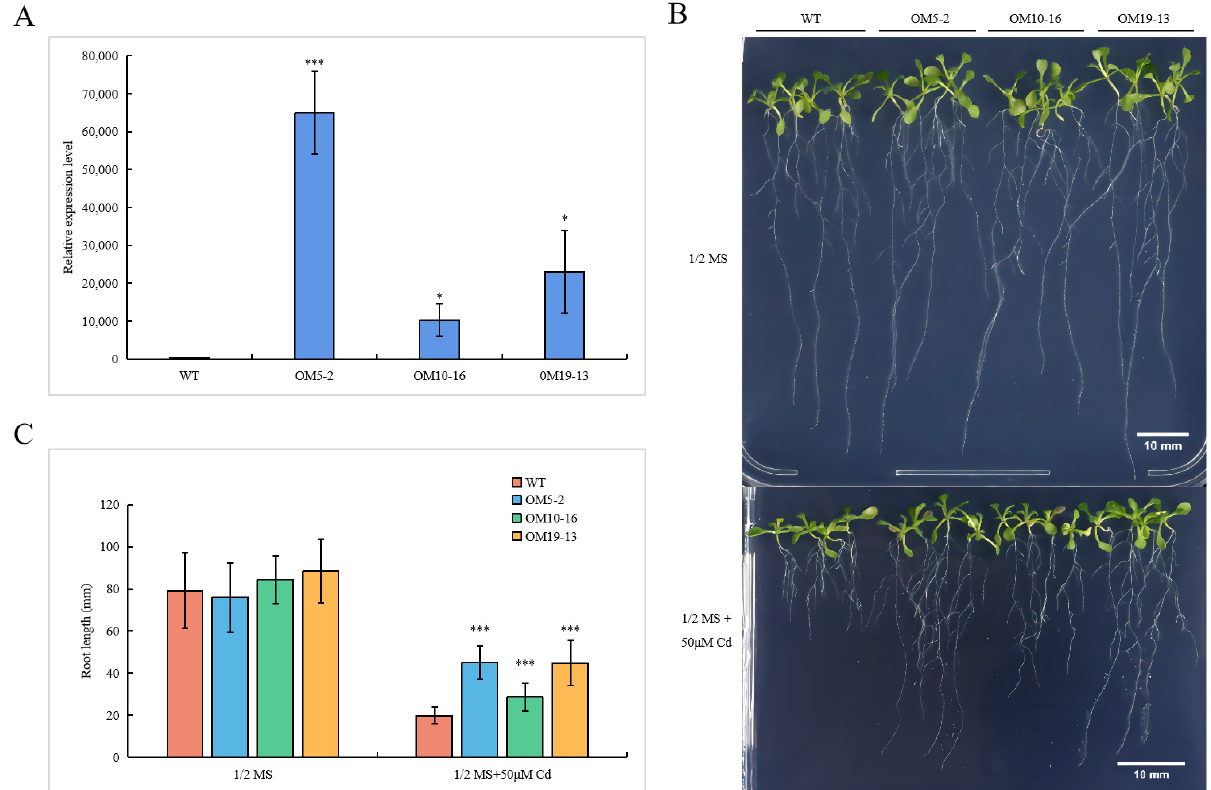
Figure 5. Analysis of PvHMA2.1 ectopically expressed lines in response to Cd treatment in A. thaliana . ( A ) Relative expression levels of PvHMA2.1 in the PvHMA2.1 ectopically expressed lines and the WT in Arabidopsis without Cd treatment. Specifically, 7-day-old Arabidopsis seedlings of the T 3 PvHMA2.1 ectopically expressed lines and the WT grown on a 1/2 MS medium were harvested for transcription detection using qPCR. The expression levels of PvHMA2.1 gene in the WT are normalized as 1. Error bars represent the standard deviations of the three replicates. ( B ) Phenotypic analysis of Arabidopsis seedlings under Cd stress. Specifically, 3-day-old Arabidopsis seedlings of the T 4 transgenic lines (OM5-2, OM10-16, and OM19-13) and the WT were grown in a 1/2 MS medium without Cd or with 50 µ M of Cd for 8 days, and photographs were taken. Scale bars are 10 mm. ( C ) Primary root lengths of Arabidopsis seedlings under Cd stress. Primary root lengths were measured using IMAGEJ 1.52, and the data represent the mean ± SD, n ≥ 21. Asterisks indicate significant differences: one asterisk indicates p < 0.05, and three asterisks indicate p < 0.001. 2.6. Cadmium Contents Reduced in PvHMA2.1 Ectopically Expressed Lines in A. thaliana